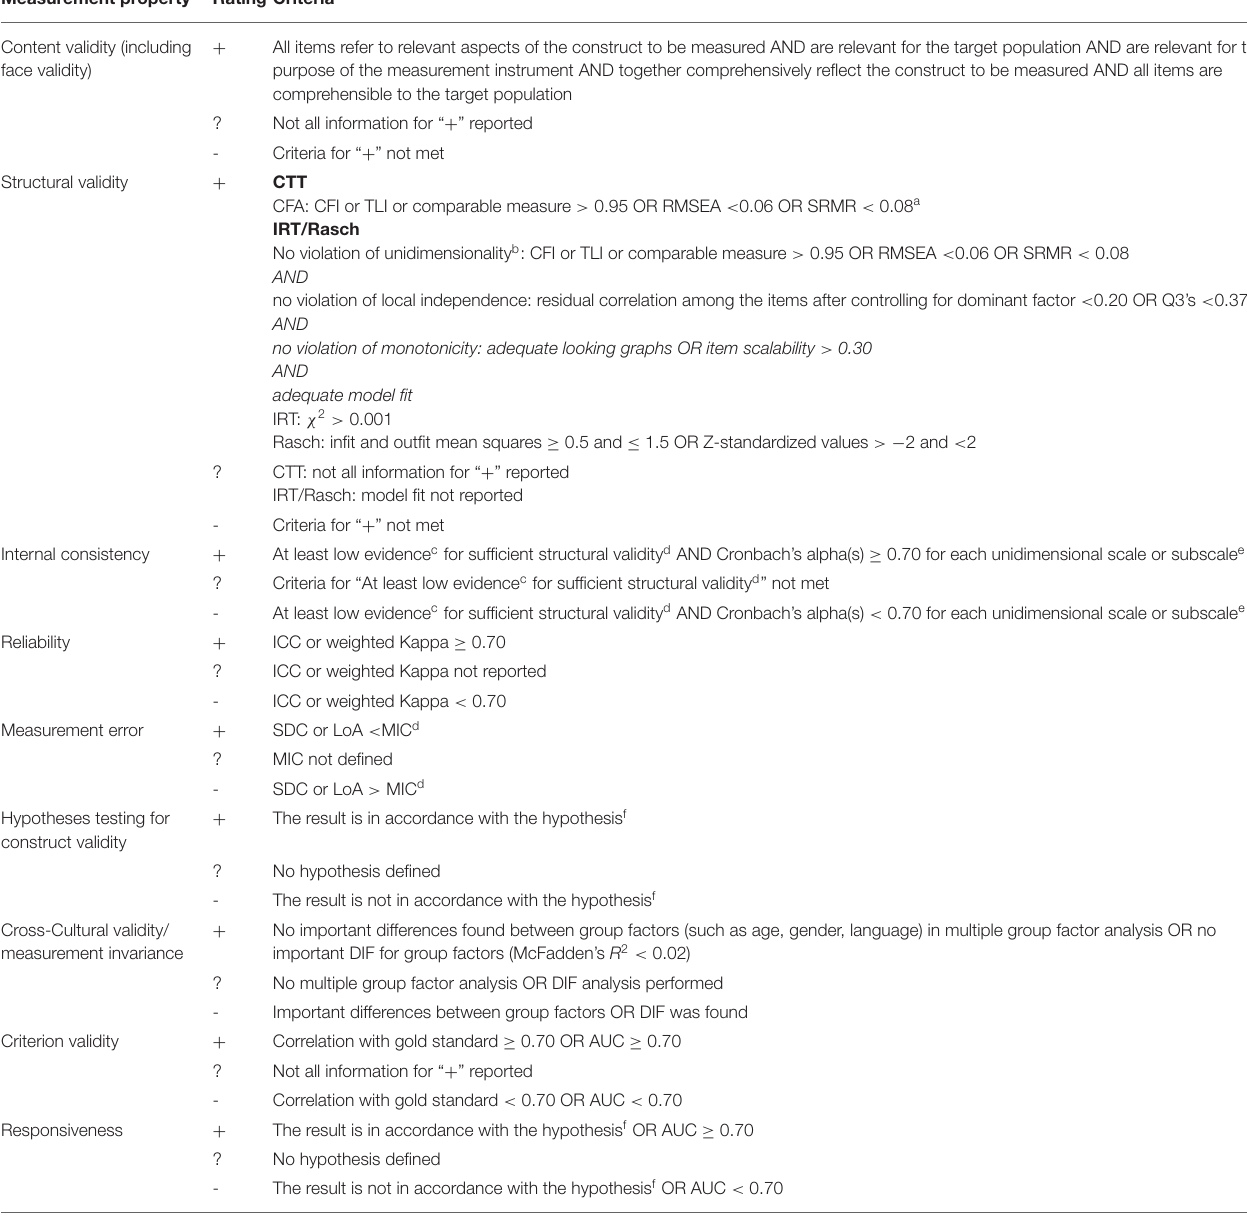
TABLE 1 | COSMIN Criteria for good measurement properties according to Prinsen et al. (2018). Measurement property Rating